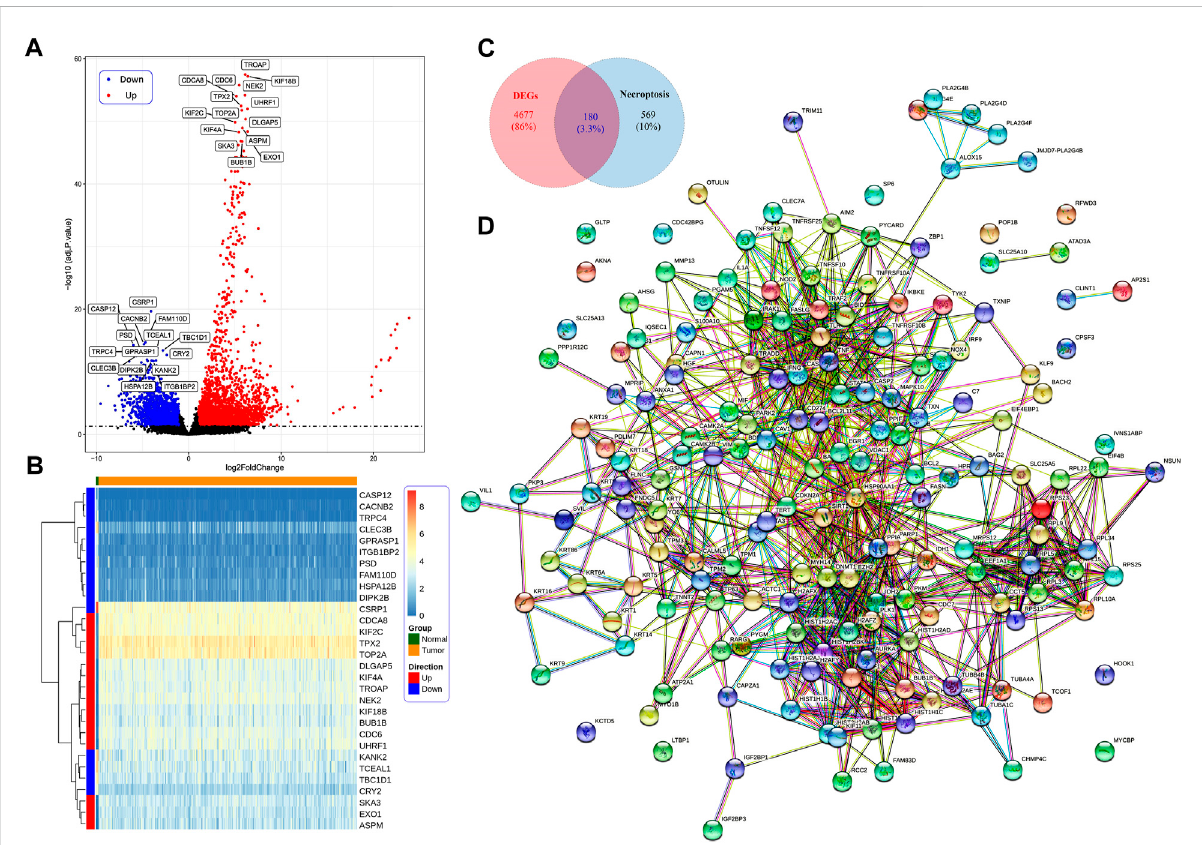
FIGURE 2 (A) Identi fi cation of differentially expressed necroptosis-related genes (DENRGs). Identi fi cation of differentially expressed genes (DEGs) in cervicalcancer(CC)tumortissueandnormalcontroltissuebasedonavolcanoplot. (B) Theexpressionofthetop15upregulatedanddownregulated genes in CC presented in a heatmap. (C) The expression of 180 DENRGs between the tumor and normal groups. (D) Protein – protein interaction network of the 180